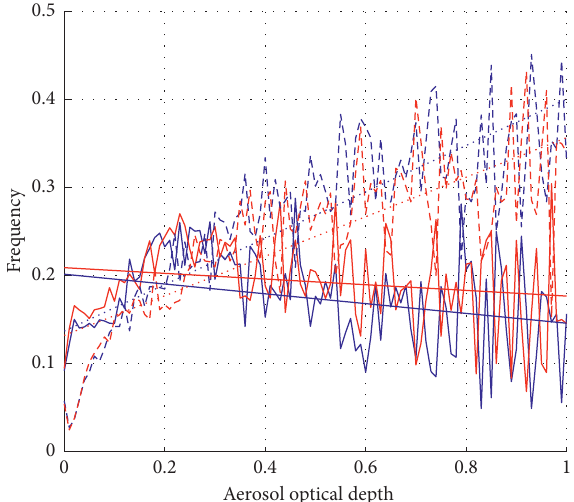
Figure 5: Comparison of the frequency of dust and polluted aerosol in summer in the abundant and deficient monsoon years (“blue solid line” is the dust aerosol of abundant monsoon years; “red solid line” is the dust aerosol of deficient monsoon years; “blue dotted line” is the polluted aerosol of abundant monsoon years; “red dotted line” is the polluted aerosol of deficient monsoon